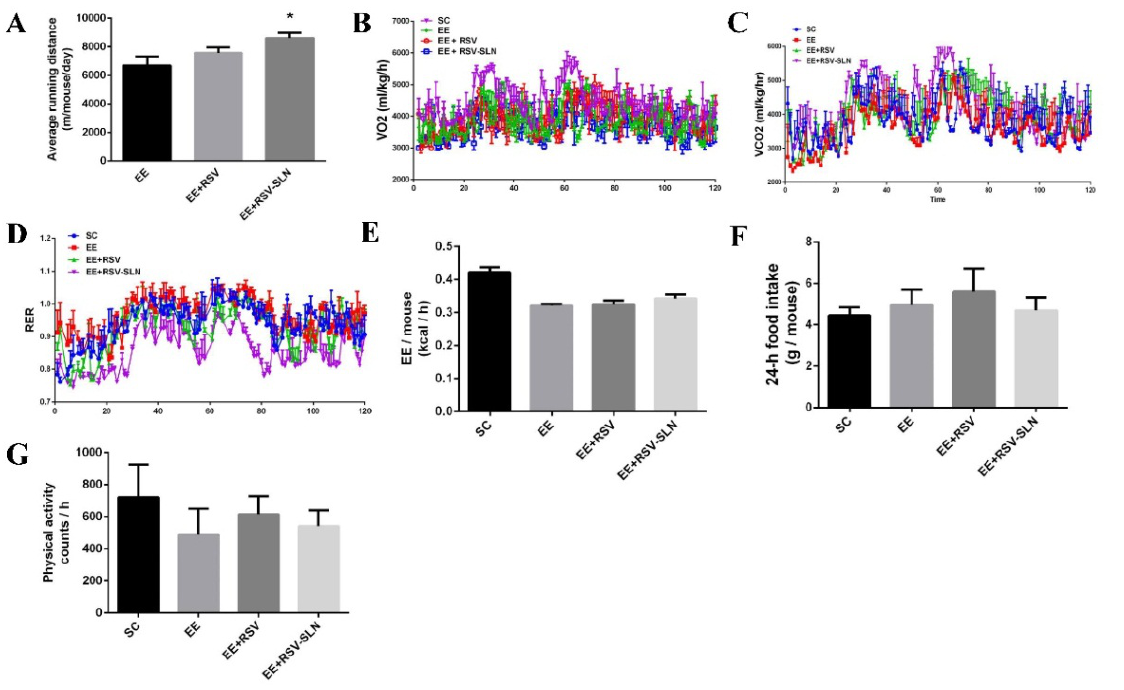
Figure 4. RSV-SLN supplementation enhances endurance performance. ( A ) Average running distances to the point of exhaustion. ( B ) Oxygen consumption (VO 2 ). ( C ) Carbon dioxide production (VCO 2 ). ( D ) Respiratory exchange ratio (RER). ( E ) Energy expenditure (EE). ( F ) Food intake for 24 h. ( G ) Physical activity of mice from four groups. * p < 0.05 vs. SC (sedentary control) group.